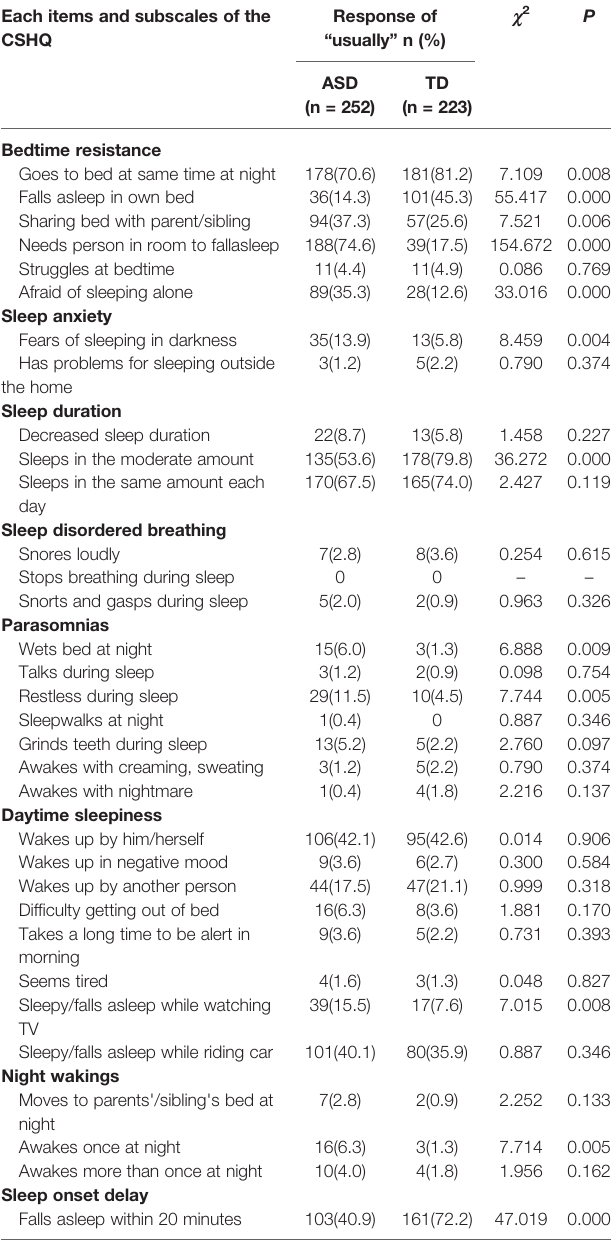
TABLE 4 | CSHQ subscale items for children with ASD and TD